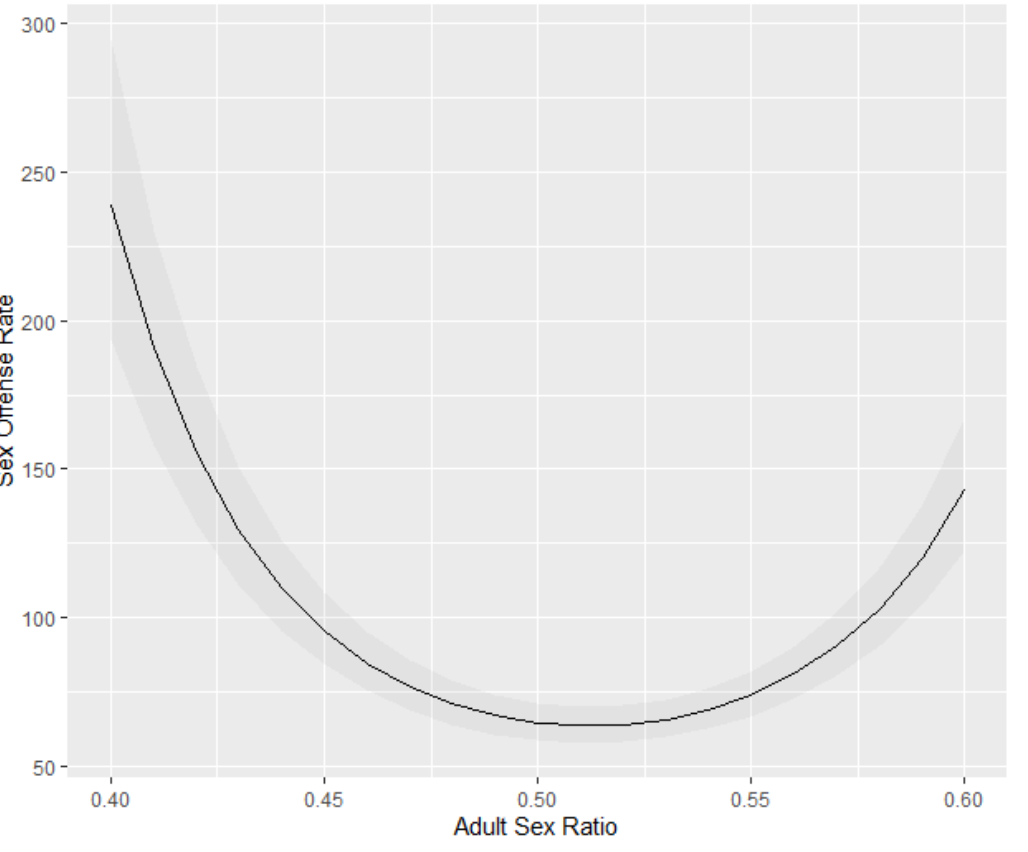
violence is occurring at higher rates when the ratio is imbalanced, regardless of the direction (though it is much higher when there are fewer men in the population). The poverty rate